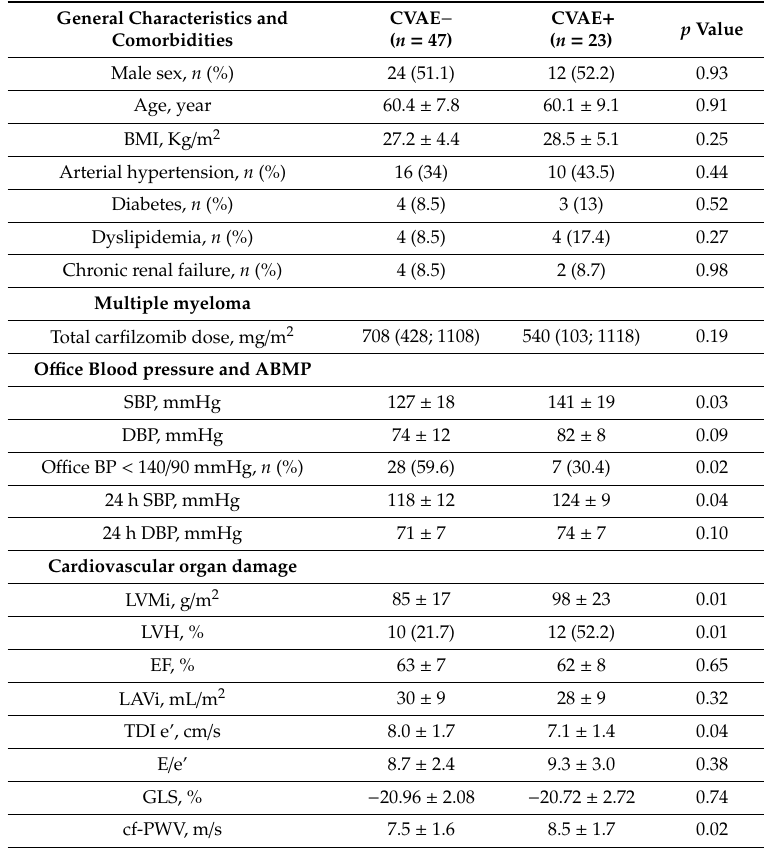
Table 4. Comparison between patients with and without cardiovascular adverse events (CVAEs) during follow